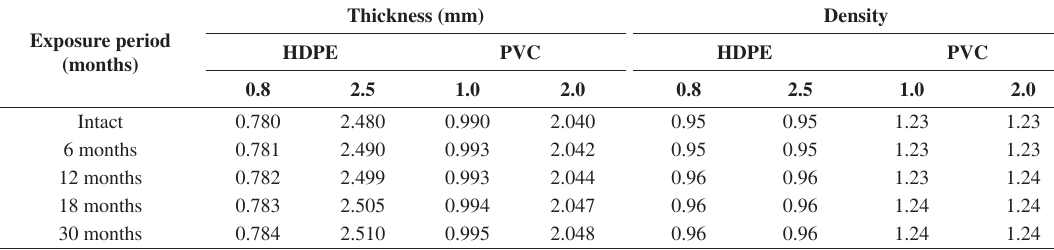
Table 1. Results of thickness and density of geomembranes after weathering exposure. Exposure period (months)